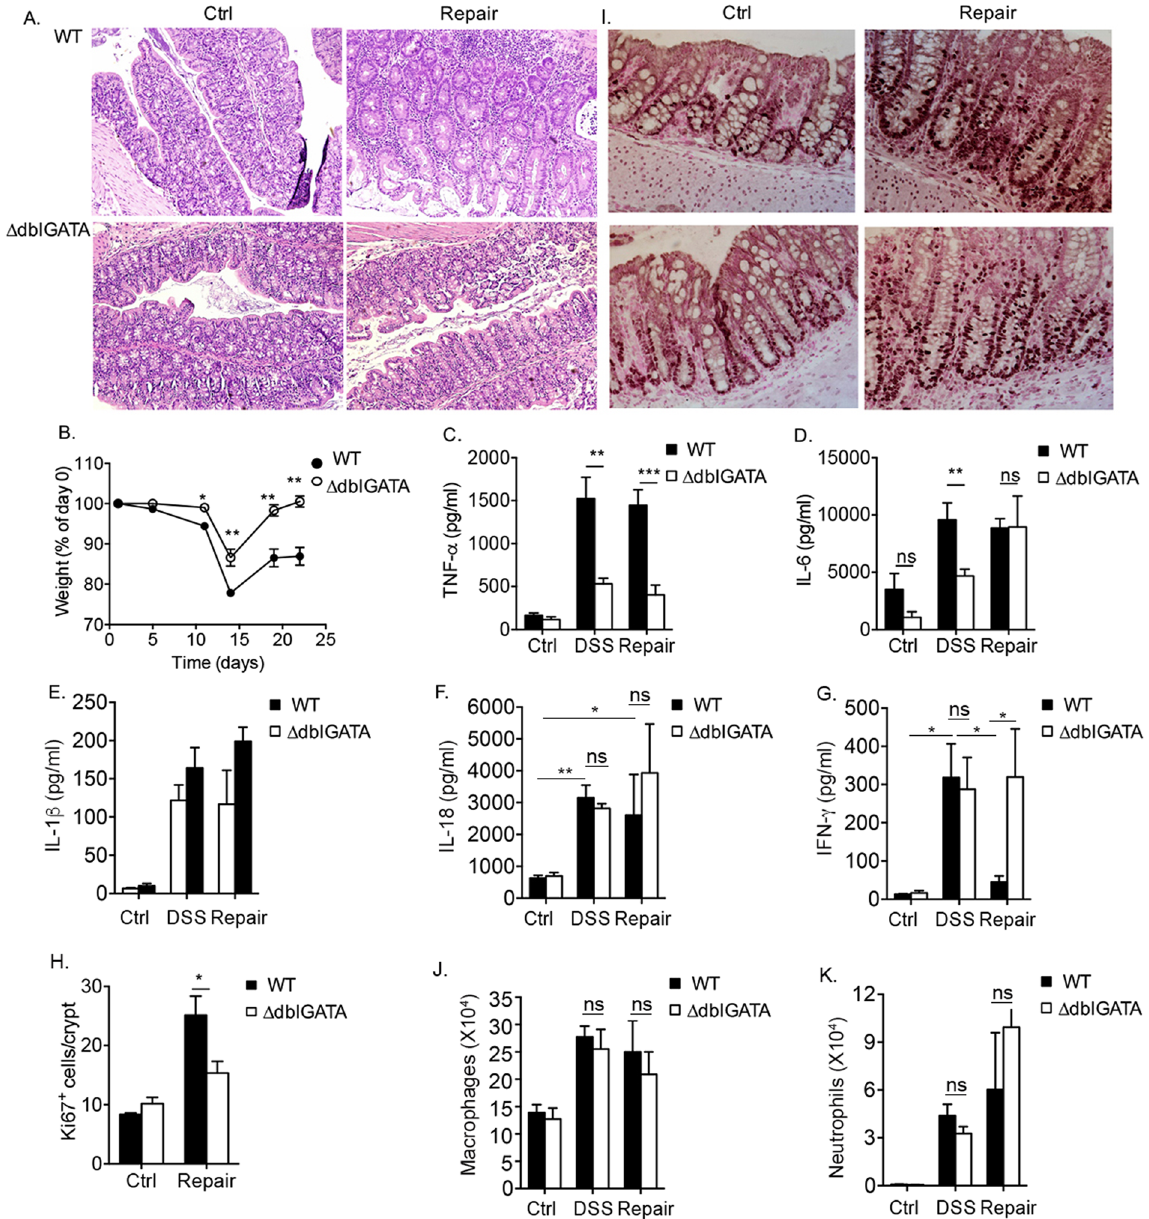
Figure 2. Accelerated mucosal healing following DSS treatment in the absence of eosinophils. Representative H&E-stained ( A ) and Ki-67-stained slides (I) from control (Ctrl) mice and mice during the repair stage. The weight of wild type (WT) and eosinophil deficient mice ( Δ dblGATA mice) was determined at the indicated time points during the experimental regimen ( B ). The expression of TNF- α ( C ), IL-6 ( D ), IL-1 β ( E ), IL-18 ( F ) IFN- γ ( G ) and quantitative analysis of Ki-67 + cells ( H ) is shown. Analysis of macrophage ( J ) and neutrophil ( K ) infiltration in the colons of wild type and ∆ dblGATA mice under baseline conditions (Ctrl), following DSS- treatment and during the repair phase. Data in ( I ) and ( E ) are representative of at least n = 3, other data are from at least n = 3 experiments, *** p < 0.001; ** p < 0.01, * p < 0.05, ns-